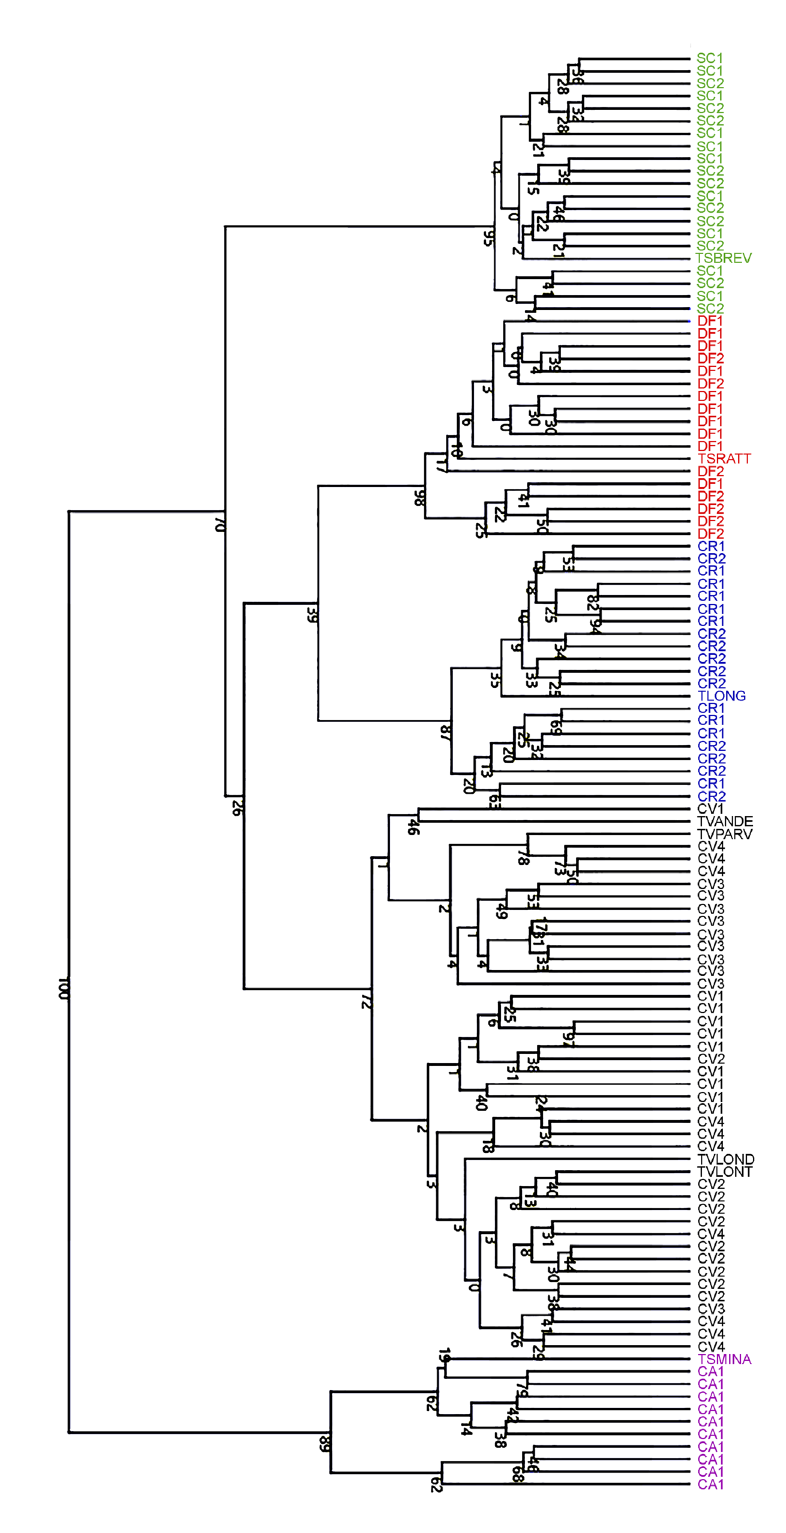
Fig. 1. Dendrogram recovered using the UPGMA method and based on the Euclidean Distance Coefficient with bootstrap values (after 1000 replicates) for the morphometric data of 11 populations and eight type specimens of the Stachytarpheta longispicata complex. For explanation of OTUs see Table